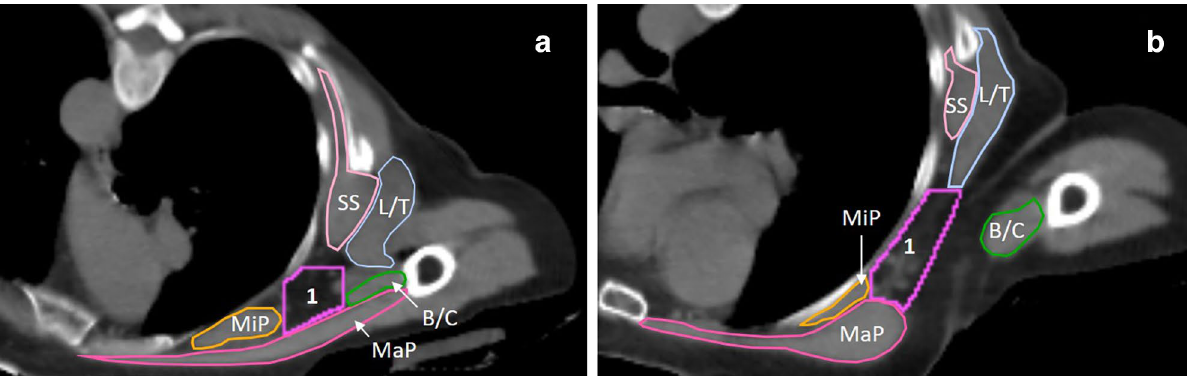
Figure 4. Adaptations to level I borders indicated on patient CT scan taken in PCP. ( a ) Shows a representation of the cranial slices, where the lateral border is defined by the medial edge of the biceps/coracobrachial muscle bundle, because the major pectoral muscle is still connected to the arm. Note that the dorsal border stops at the ventral edge of the latissimus dorsi/teres major muscle bundle here, because this reaches more ventrally than the ventral edge of the subscapular muscle at this level. ( b ) Shows a representation of the more caudal slices in level I (of the same patient) where the major pectoral muscle is no longer connected to the arm and the lateral border is formed by connecting the lateral edge of the major pectoral muscle to the ventral edge of the latissimus dorsi/ teres major muscle bundle. Light pink (SS) = subscapular muscle, light blue (L/T) = latissimus dorsi/teres major muscle bundle, purple (1) = level I, green (B/C) = biceps/coracobrachial muscle bundle, orange (MiP) = minor pectoral muscle, dark pink (MaP) = major pectoral